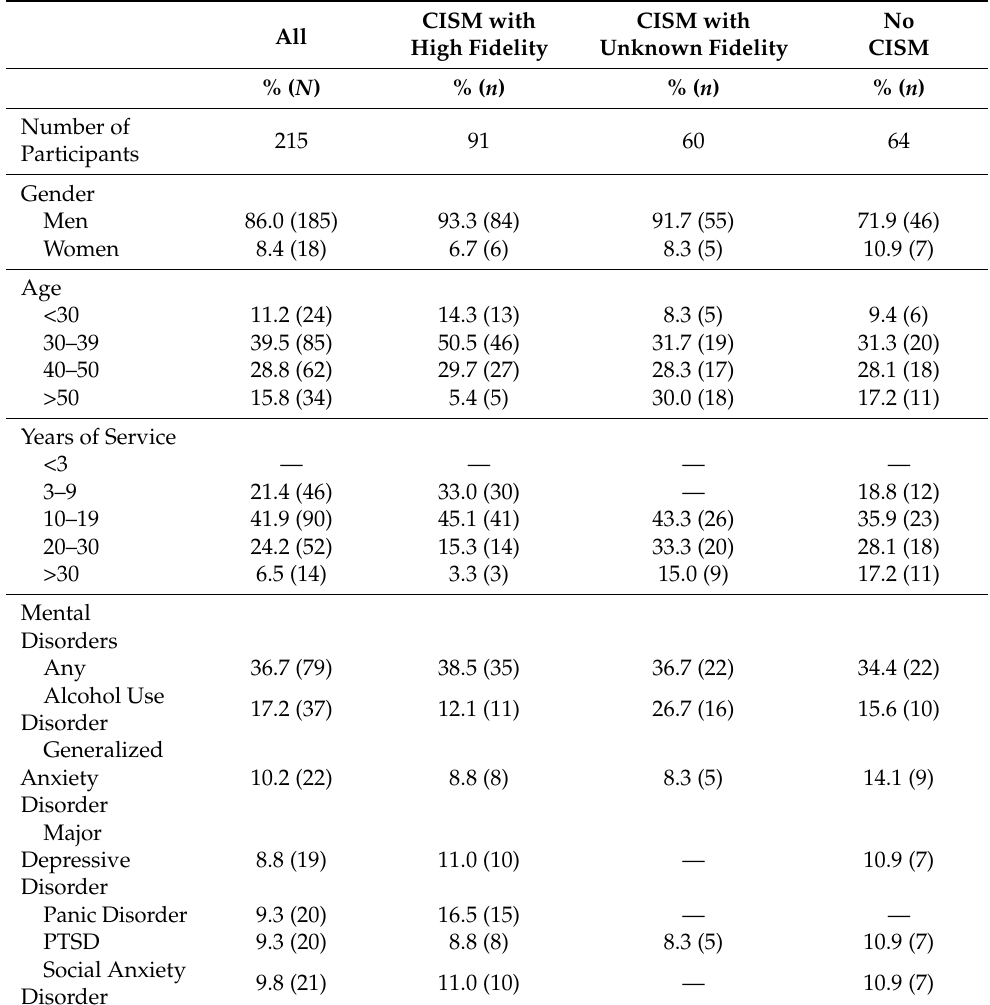
Table 1. Individual differences and mental disorders based on different CISM